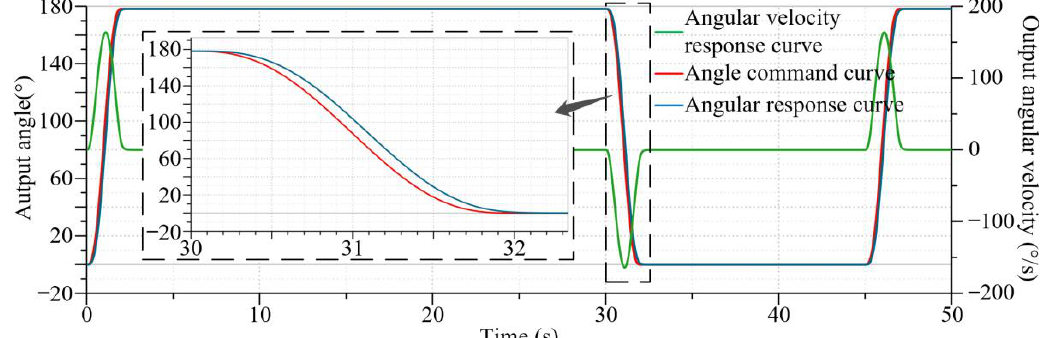
Figure 18. Dynamic performance simulation results under working condition 3.